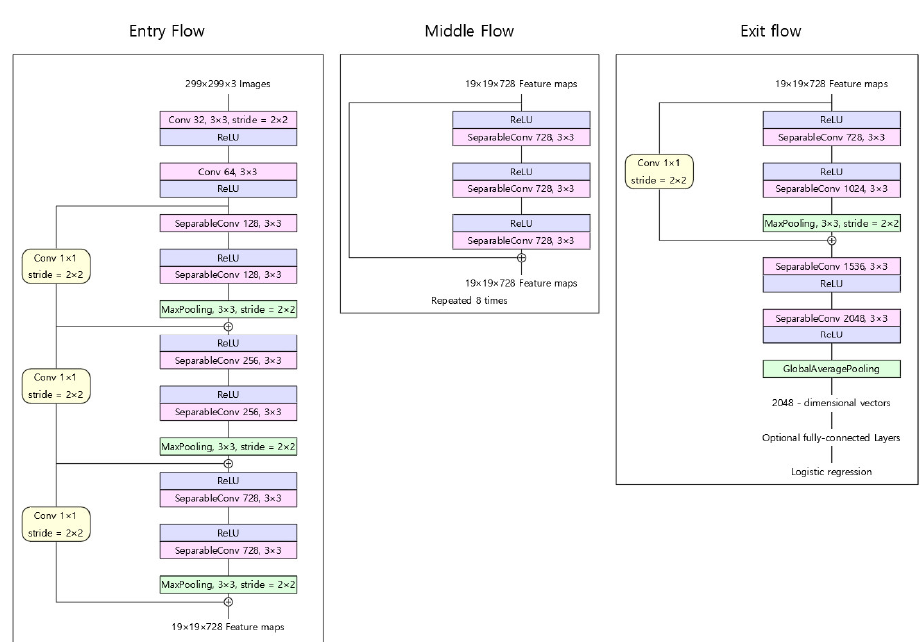
Figure 4. Xception Figure 4. Xception model.